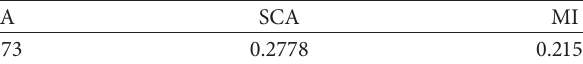
Table 5: Indexes of cultural industry trade.